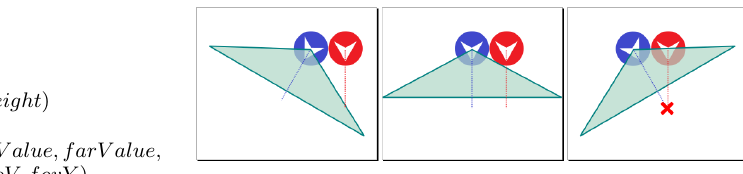
(left) The angle between the trajectories of the agents is greater than zero. They are getting away from each other. (center) The angle between the trajectories of the agents is zero. (right) The angle between the trajectories of the agents is lower than zero. They are in a collision route.